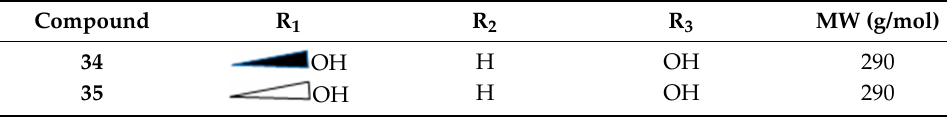
Table 4. Catechin and epicatechin.